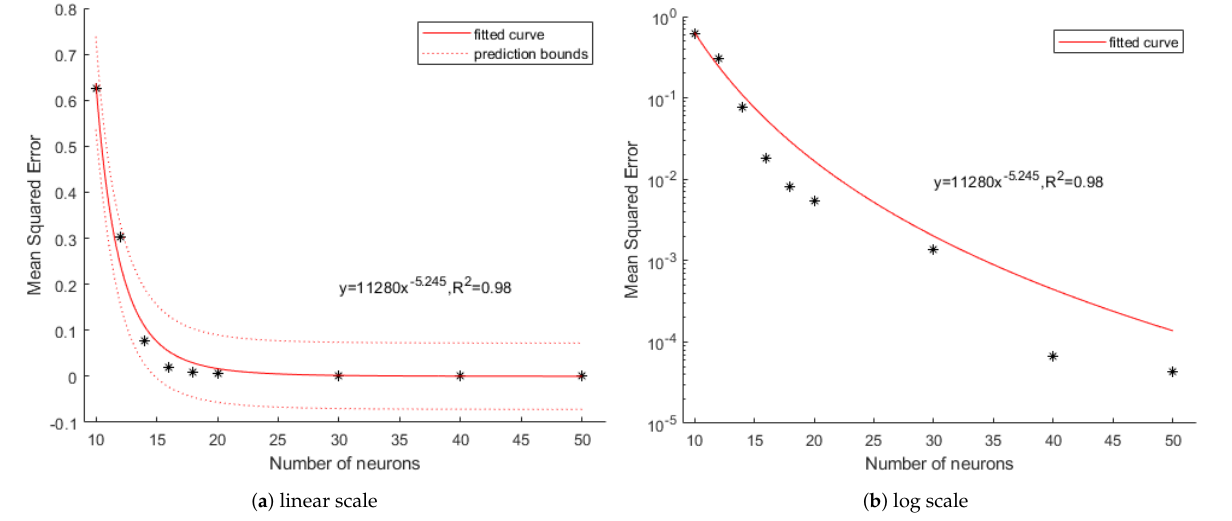
Figure 10. Mean square error of torque by the number of neurons.